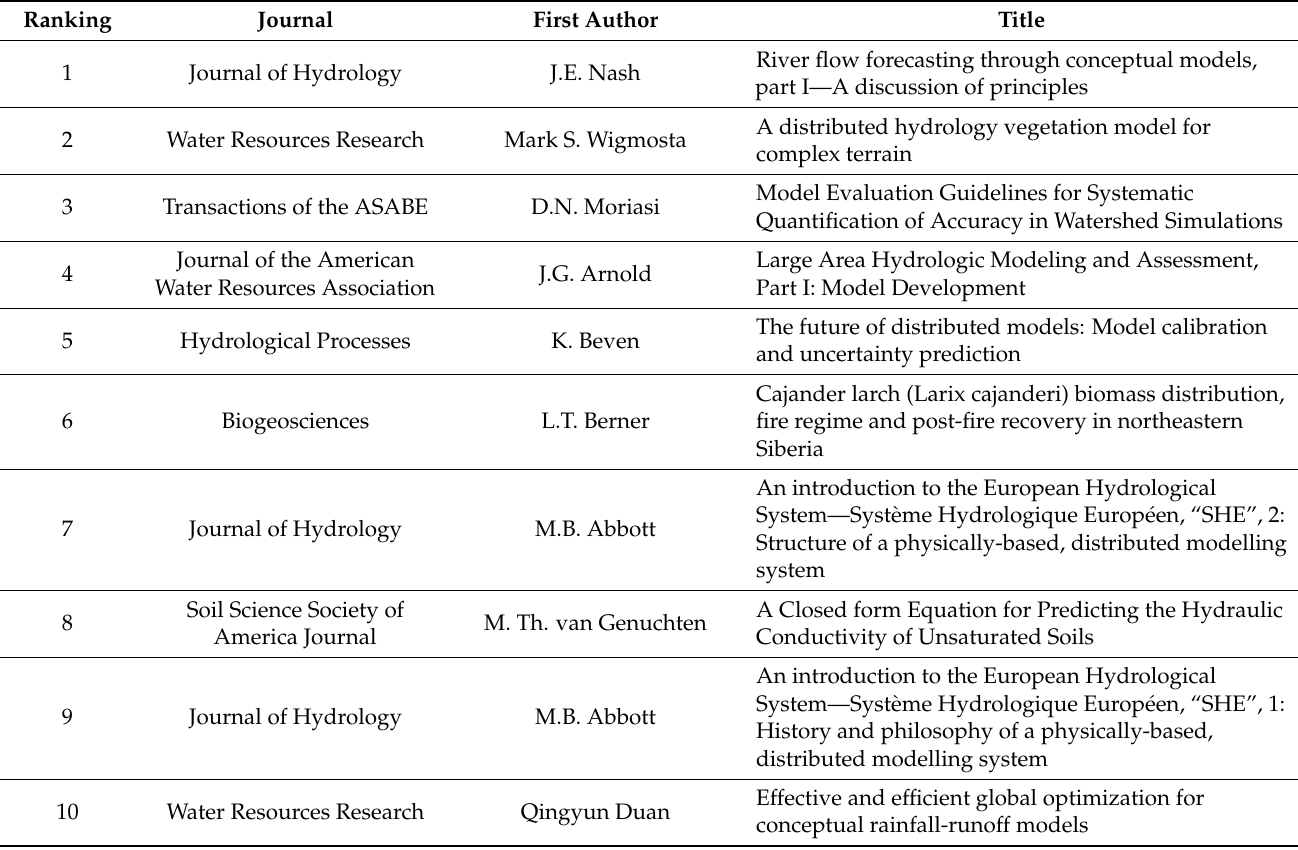
Table 3. Top ten most highly cited documents in the research field of distributed hydrological